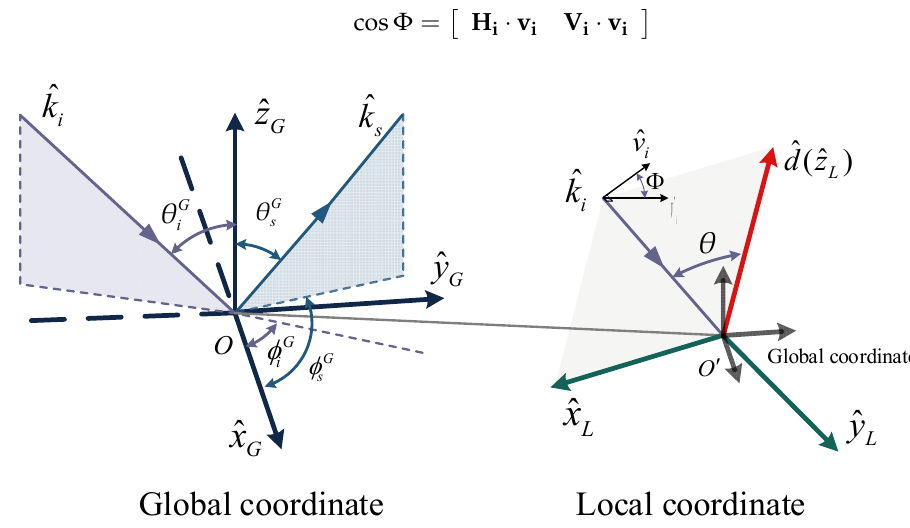
Figure 3. Diagram of the global coordinate and the chaff local coordinate systems.